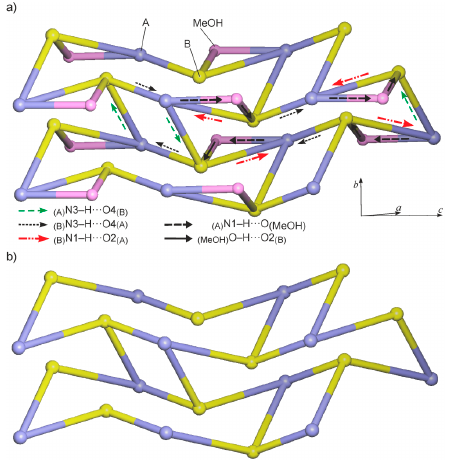
Figure 3. HBS of 1MH , represented as a graph according to ref. [21]: ( a ) the complete L(4 4 ) 2 .2 2 [(3.4.8 2 .9 2 ) 2 (3)] structure and ( b ) the L(4 4 ) 2 [4.8 2 - fes ] substructure formed by the H-bonded molecules of 1 .